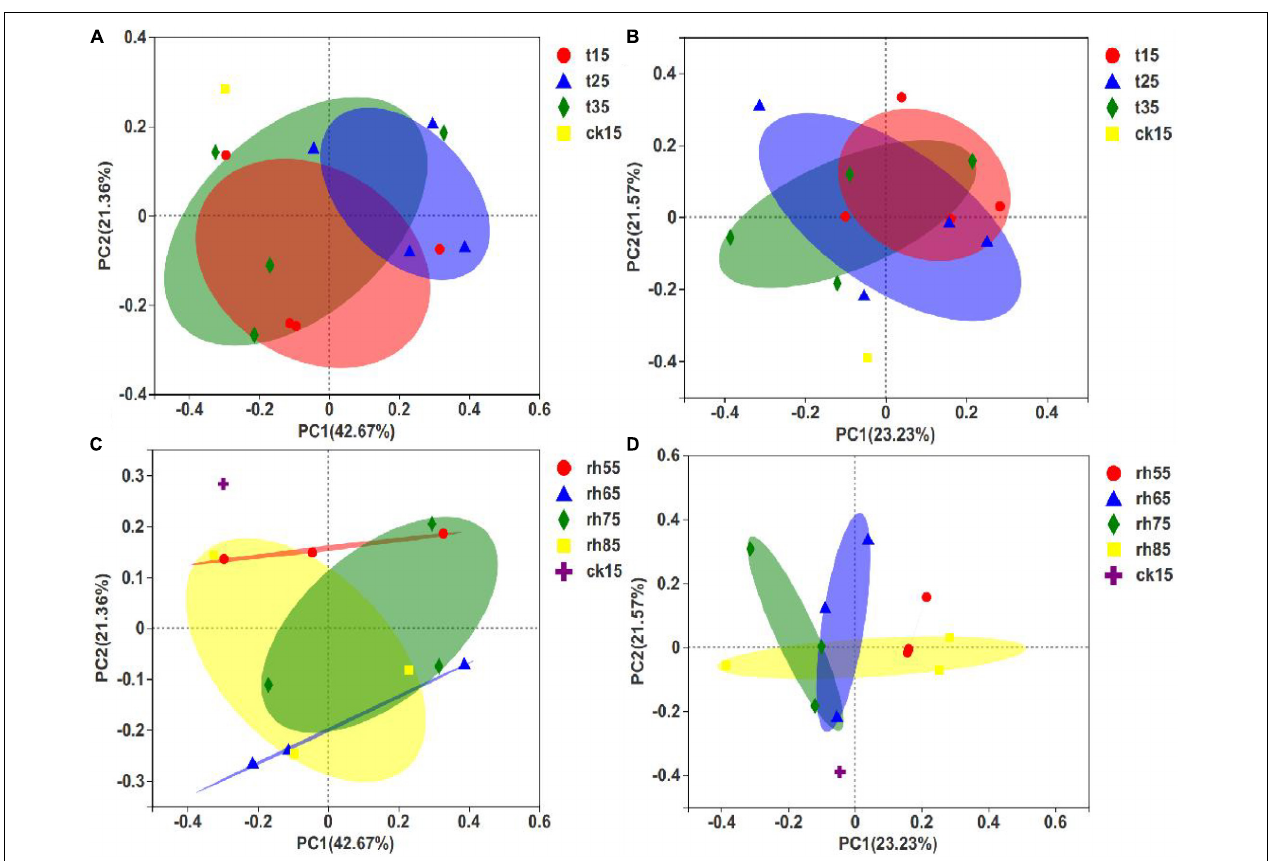
FIGURE 7 | PCoA of barley fungal communities under different storage conditions. Each sample point in the figure represents a different storage condition. The closer the distance, the higher the community similarity, which shows that each storage condition has affected the initial barley and the fungal community has changed. (A) PCoA between different temperatures after 180 days of storage; (B) PCoA between different temperatures after 360 days of storage; (C) PCoA for differing humidity after 180 days of storage; (D) PCoA for differing humidity after 360 days of